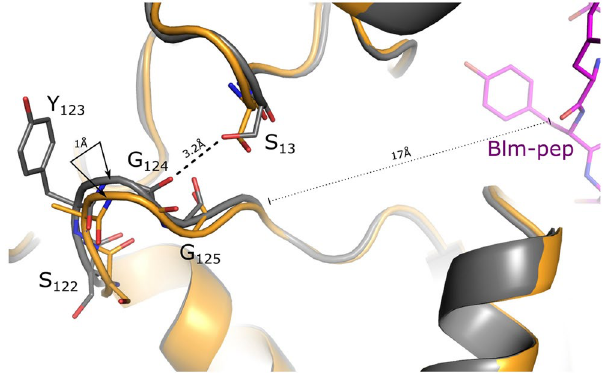
Figure 4. Distal conformational change of the 20S induced by binding of Blm-pep. The change involves the highly conserved loop, which is a part of the α -annulus regulating the substrate access to the catalytic center. Color coding is as follows: grey - latent proteasome (1RYP); beige – the proteasome bound to